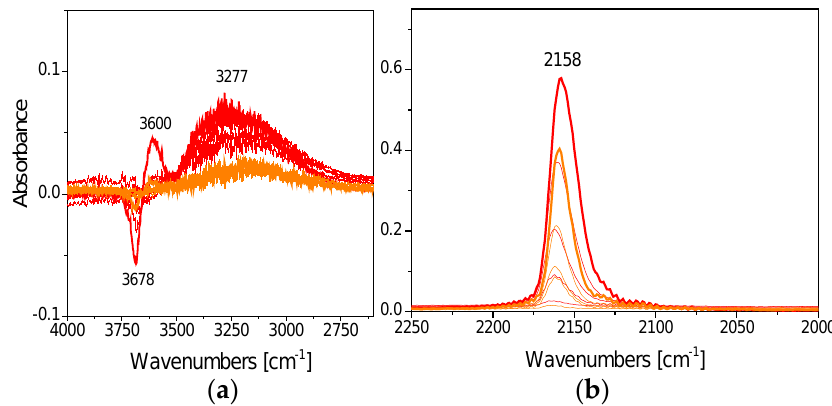
Figure 13. ( a ) Comparison among the FTIR spectra collected upon 5 mbar CO adsorption and at reducing CO pressures at − 170 °C on TiO 2 (red curves) and I1.0Cu/TiO 2 (orange curves) in the OH stretching; ( b ) and in the carbonylic regions.